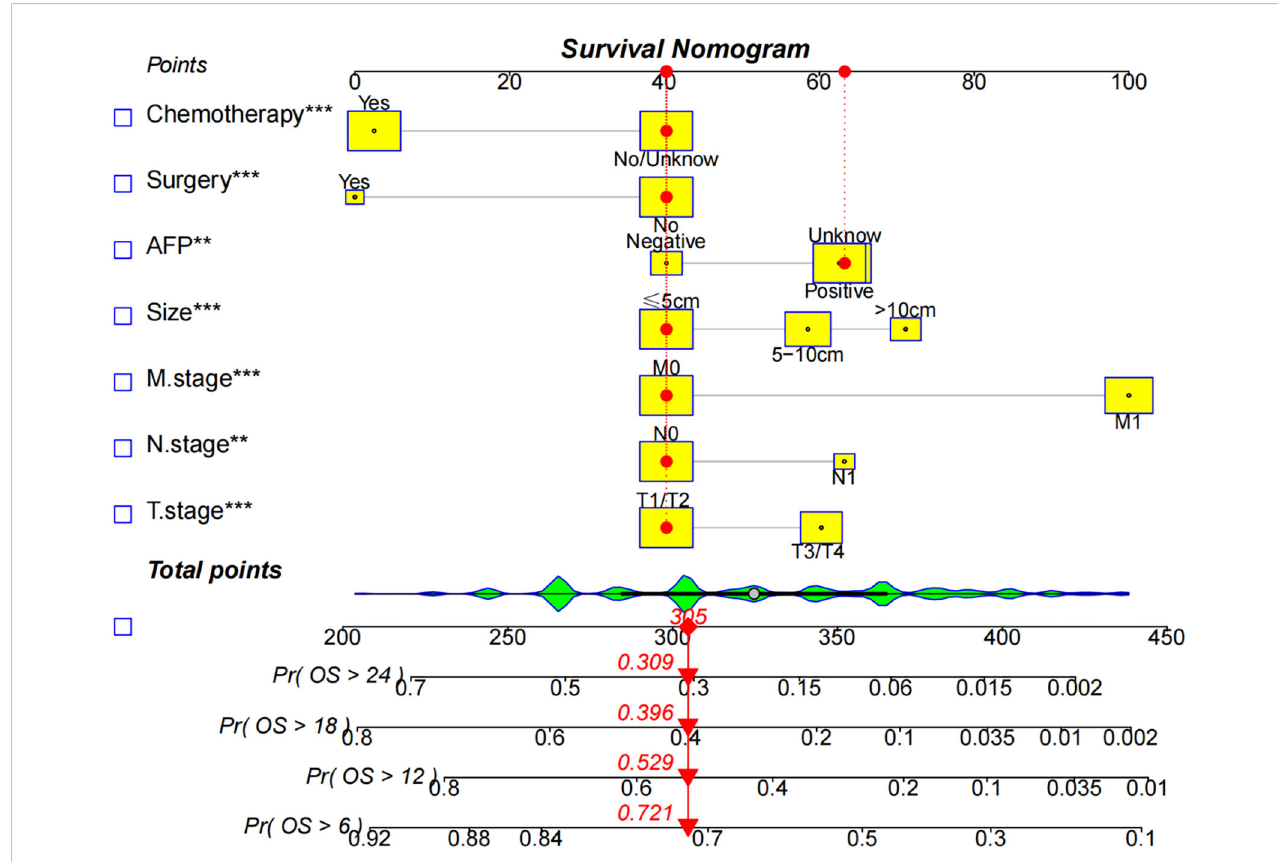
FIGURE 3 The nomogram predicts the 6-,12-,18-, and 24- month OS rates in HCC patients with EBRT. Give each factor a point based on the nomogram, the total points were obtained by adding the given points of all factors, the estimated 6-,12-,18-, and 24-months probabilities of OS of the individual patient can be easily obtained from the nomogram based on the total